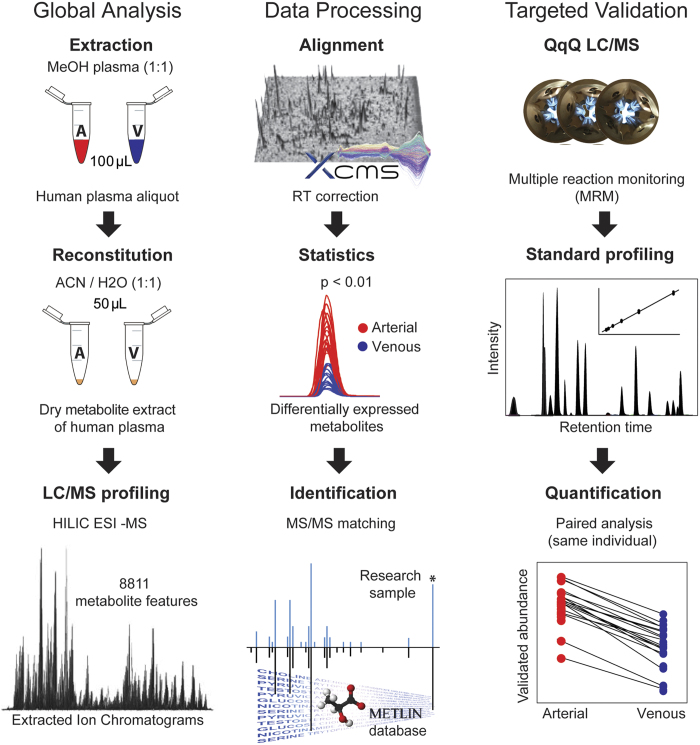
Three consecutive steps in metabolomic workflow.Global profiling summarizes the experimental design including metabolite extraction and reconstitution protocol prior to untargeted HILIC/MS profiling in ESI negative mode. LC/MS data acquisition was followed by retention time correction and chromatogram alignment. Metabolite features whose levels significantly changed (p < 0.01) in venous vs. arterial plasma were filtered out and identified by MS/MS matching. The identified metabolites were quantified by targeted MRM analysis using standard compounds. All drawings were created by authors except the Eppendorf schemes that were downloaded as a vector clip art from the website www.clker.com.